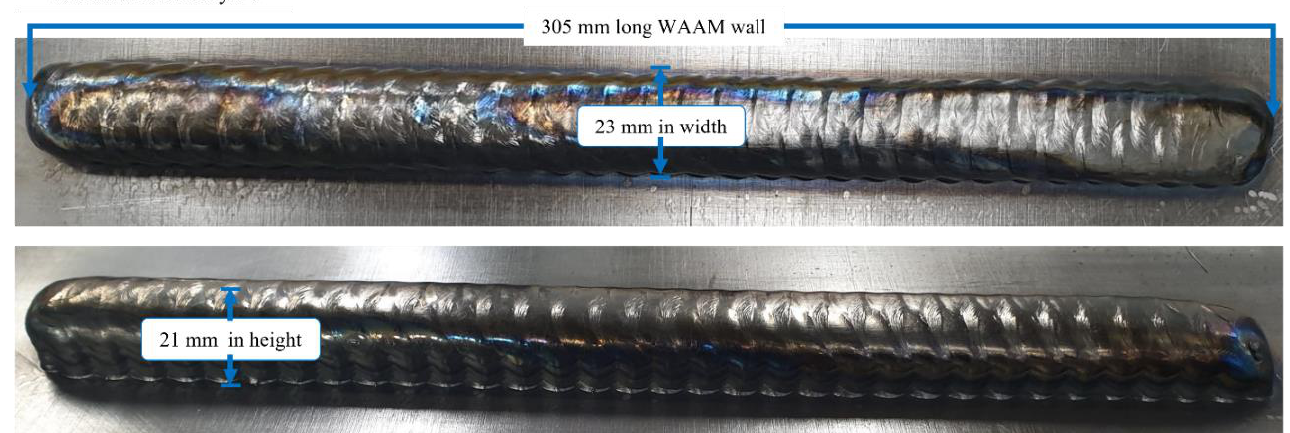
Figure 7. Completed experimental wall and its